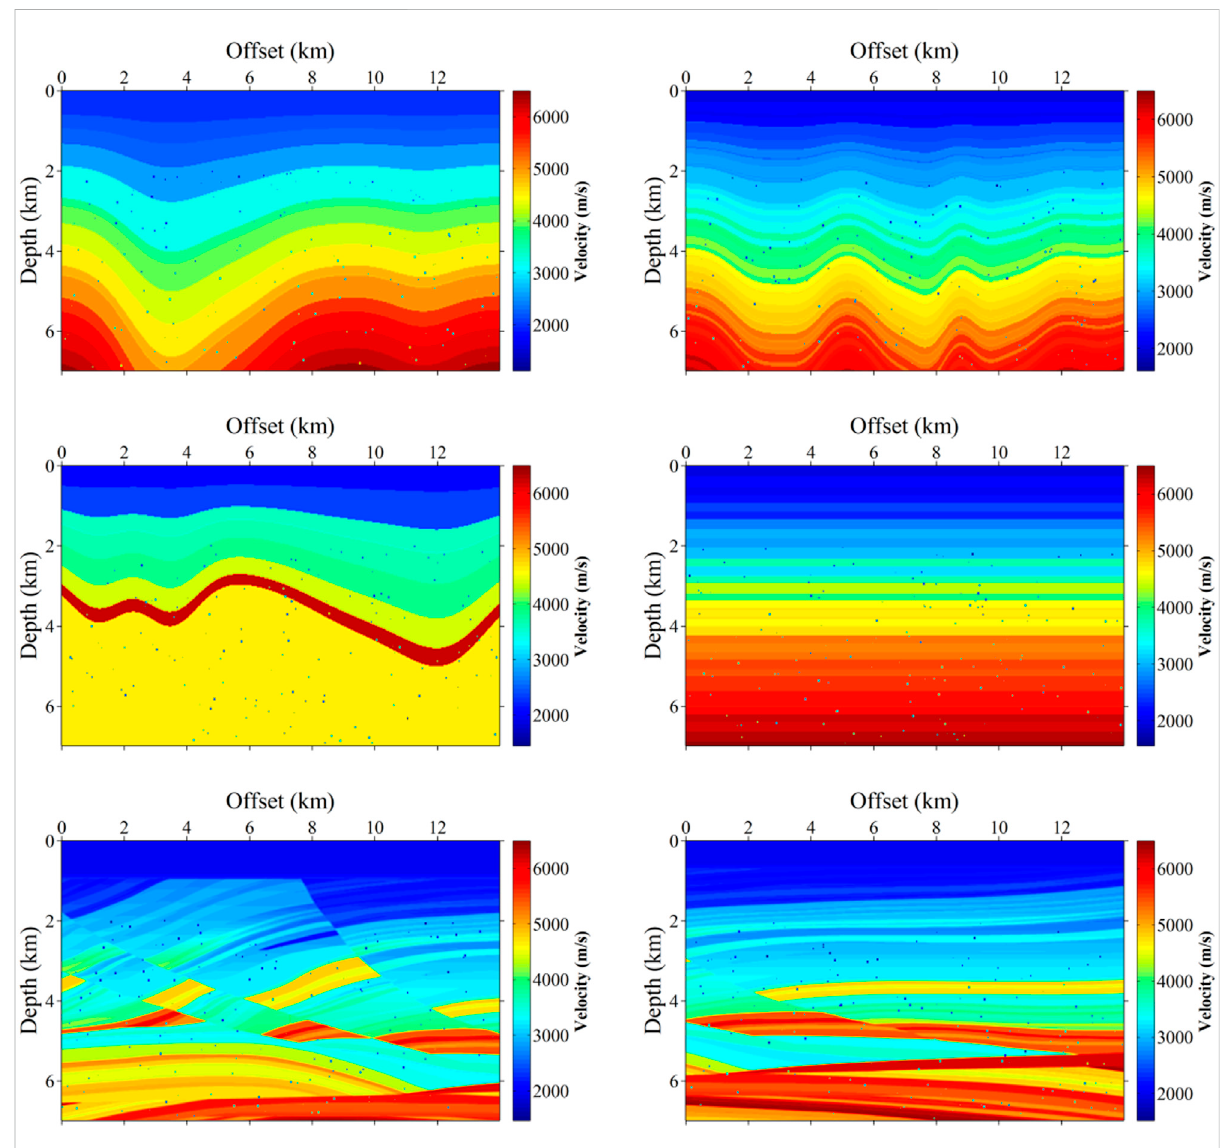
FIGURE 2 Sixrepresentativevelocitymodelswithkarst caves, which aregeneratedbyadding diffractionpoints(coloredsquares)to thevelocitymodelsin Figure